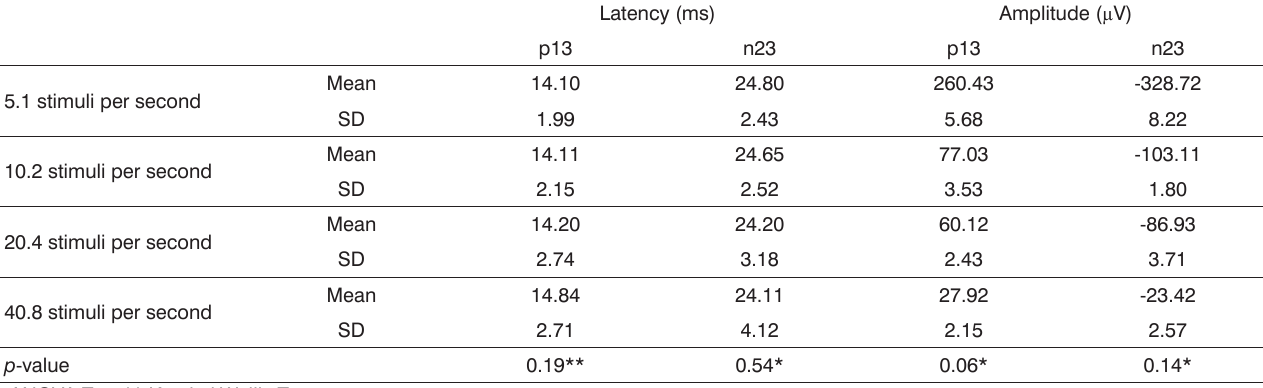
Table 1. VEMP latencies and amplitudes for each stimulation rate.